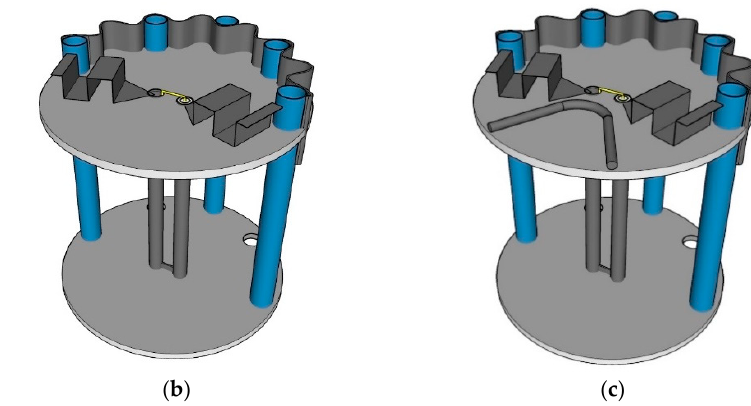
Figure 7. Evolutionary stages of the portable antenna scheme: ( a ) first generation, ( b ) second generation, and ( c ) third generation.